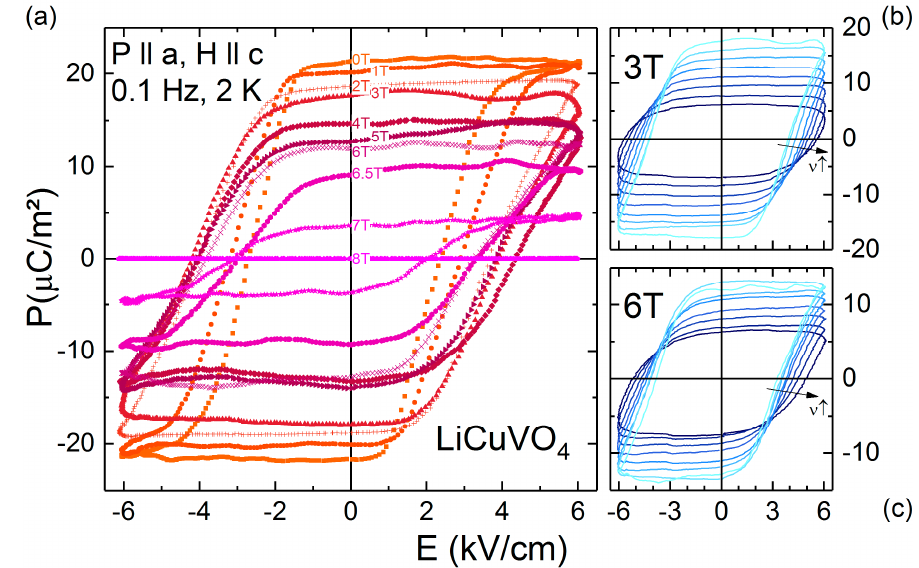
Figure 3. ( a ) Ferroelectric hysteresis loops of a LiCuVO 4 single crystal measured at 2 K and 0.1 Hz in electrical fields up to 6 kV·cm − 1 (with background subtracted); ( b , c ) show frequency dependent hysteresis loops (0.1 Hz < ν < 300 Hz) in magnetic fields of 3 T and 6 T, respectively. For ( a – c ), P is measured along the a direction. Static magnetic fields up to 8 T are applied along the c direction.